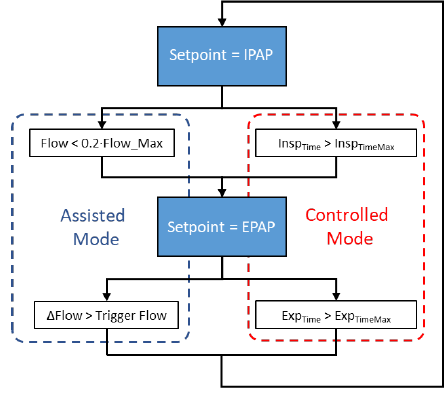
Figure 1. Flow diagram of the ventilator operating mode.